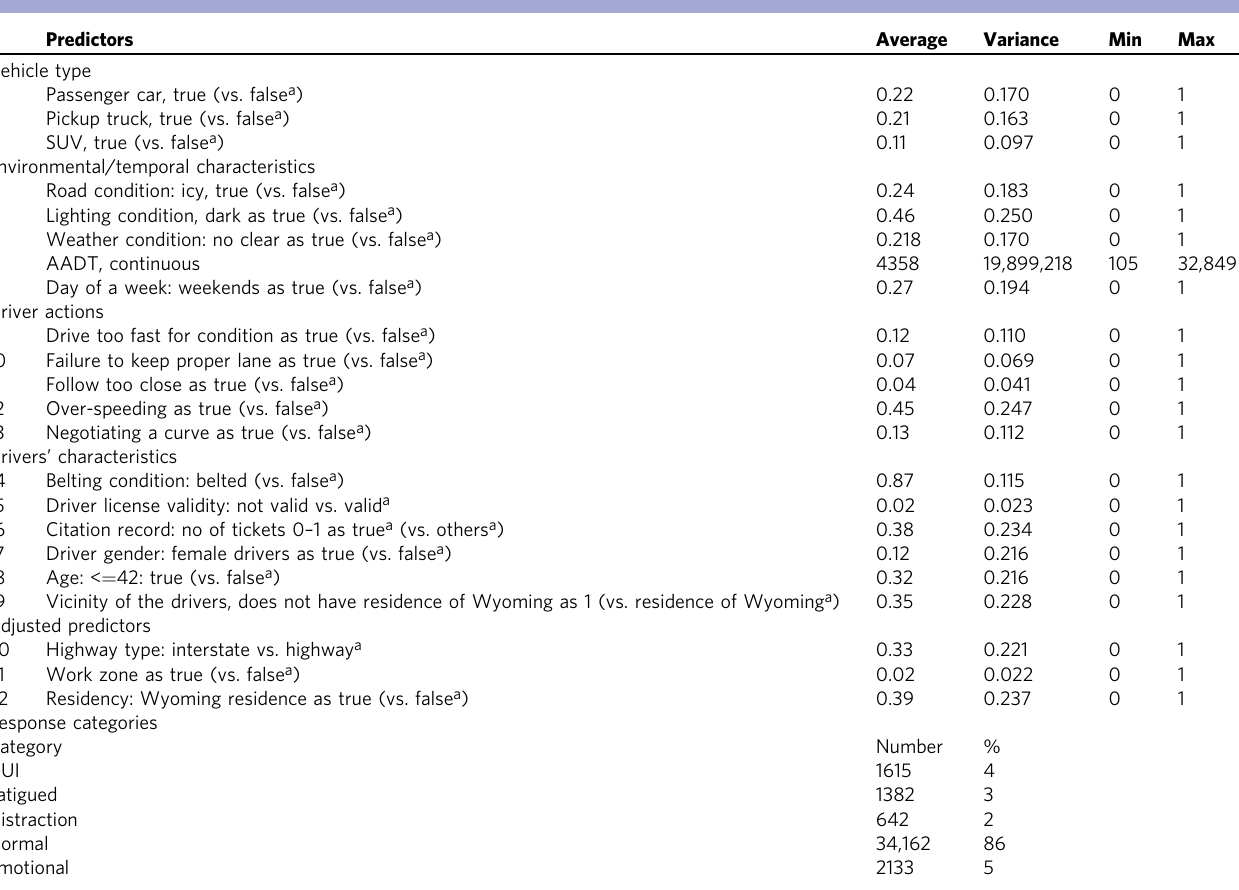
Table 1 descriptive statistics of important